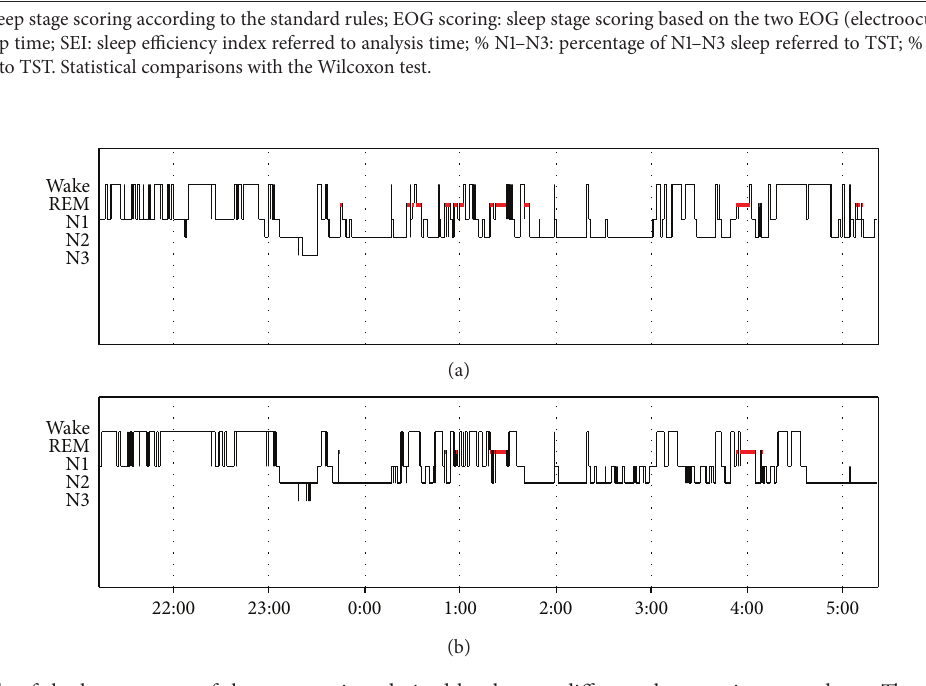
Figure 1: Example of the hypnograms of the same patient derived by the two different sleep staging procedures. The upper hypnogram represents standard sleep staging and the lower hypnogram represents EOG scoring. The hypnograms resemble each other but there are differences in both sleep efficiency (69% by standard sleep staging, 59% by EOG-scoring) and the arrangement of the sleep stages. The patient had moderate OSA (AHI 18.8/h).